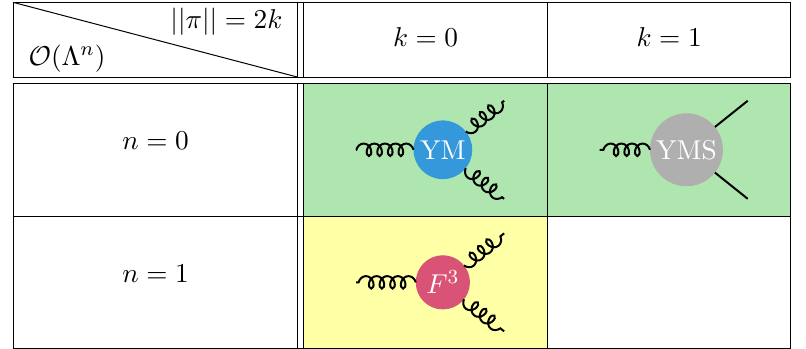
Table 1 . Three-point amplitudes for 2 k pions — Green cells contain amplitudes generated by eq. (3.1). The additional Tr( F 3 ) interaction highlighted in yellow was needed in eq. (3.8) for double-copy consistency.